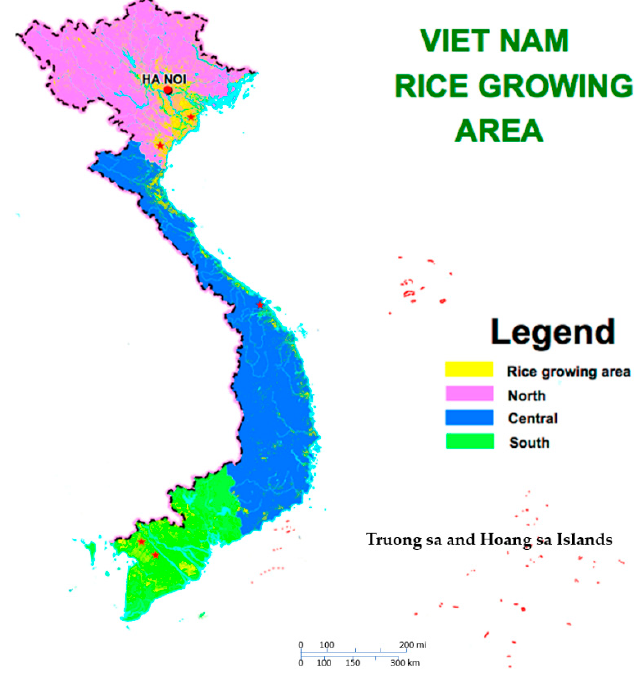
Figure 1. Ecological rice-growing map in Vietnam